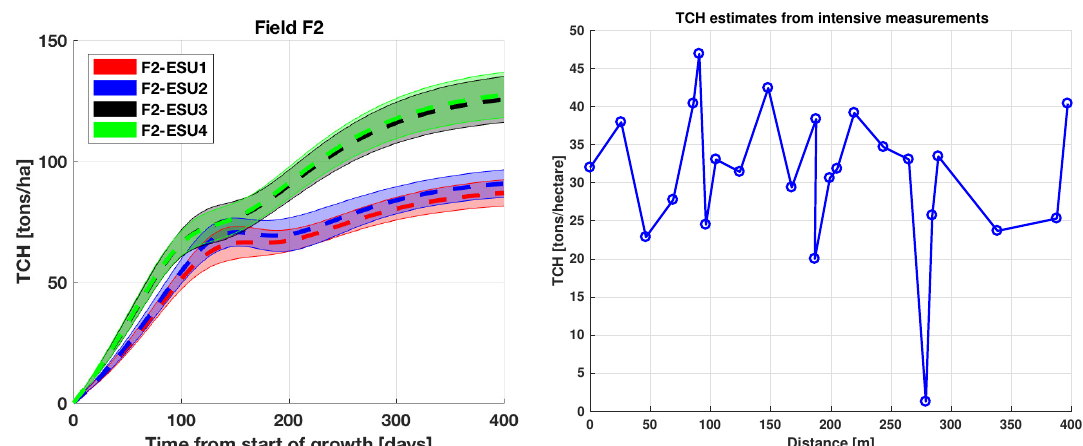
Figure 4. Estimated tons cane per hectare (TCH) over growth time for each elementary sampling unit (ESU) of Field F2, along with the associated uncertainties ( left ). F2-ESU1 and F2-ESU2 nearly overlap; similarly for F2-ESU3 and F2-ESU4. Profile of biomass estimates 400 m along from the intensive measurement at Field F2 ( right